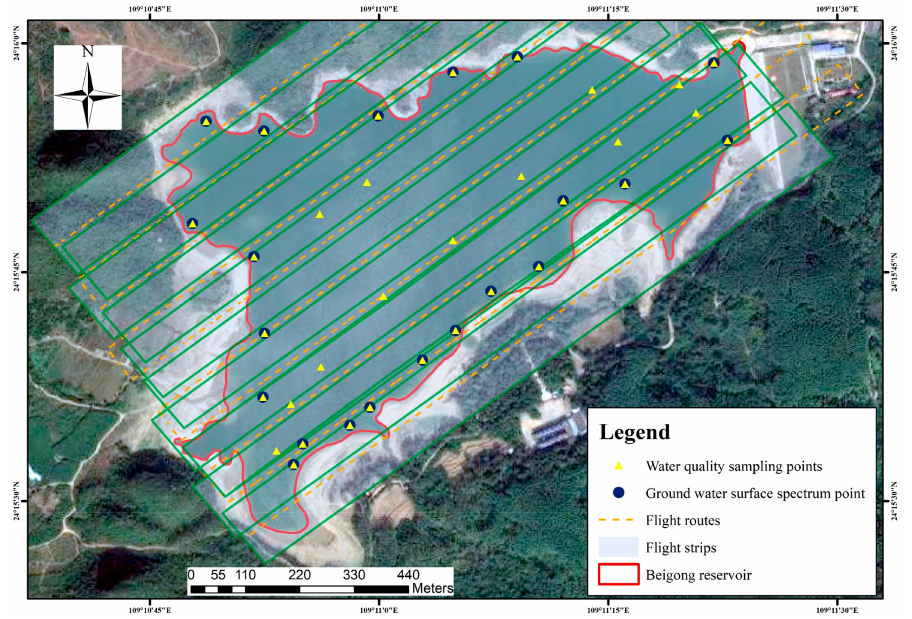
Figure 1. The study area and sampling